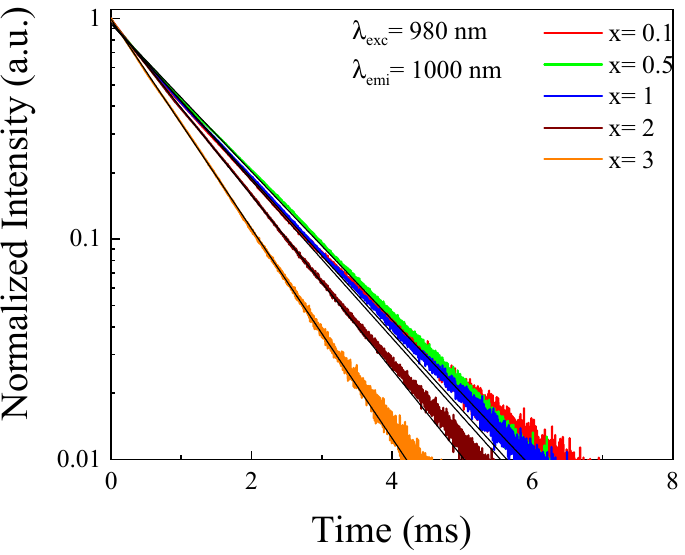
Figure 4. Decay curves of Yb 3+ in 2.5Tb 3+ -xYb 3+ co-doped phosphate glasses. To get more information about the energy transfer mechanism from Tb 3+ to Yb 3+ , the excitation power measurements for 2.5 Tb 3+ -1Yb 3+ co-doped phosphate glass were performed and shown in Figure 5. The slope value for Tb 3+ : 5 D 4 → 7 F 5 emission is 1.0, exhibiting a linear relationship between the intensity of Tb 3+ luminescence and excitation power. However, according to the power dependence property for the luminescence of Yb 3+ , the slope value for Yb 3+ : 2 F 5/2 → 2 F 7/2 was 0.83. Duan et al. developed a Quantum Cutting (QC) model using rate equations in order to explain the sublinear slopes [9]. The slope of Yb 3+ intensity power dependence was between 0.5 and 1, which indicated the coexistence of two different energy transfer mechanisms in Tb 3+ -Yb 3+ co-doped phosphate glass, such as one photon process where the Yb 3+ emission intensity exhibited a linear relation with the excitation power (theory slope of 1.0). This mechanism consists of our system being excited to the 5 D 4 level transfer of its energy (ET) to one Yb 3+ ions by means of a virtual level (Figure 1). From this state, the system relaxed to lower states of Tb 3+ ions [20]. The second mechanism required a two photons process (theory slope of 0.5), considering that the energy of Tb 3+ transition ( 5 D 4 → 7 F 5 ) is approximately twice to Yb 3+ transition ( 2 F 5/2 → 2 F 7/2 ). Then the Tb 3+ ion excited to 5 D 4 level could transfer the energy to two Yb 3+ ions via down-conversion process (DC) emitting two 980 near infrared photons (Figure